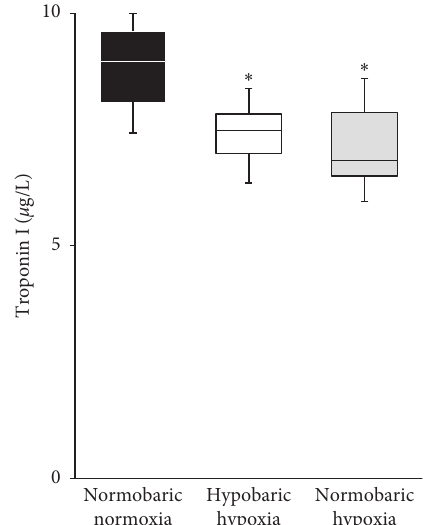
Figure 4: Plasma concentrations of troponin I in the three groups. Blood samples were collected from each group after 30 min of ischemia and 60min of reperfusion. Data are shown as median and interquartile range (IQR), n � 8 rats per group. ∗ p < 0.01 vs. nor- mobaric normoxia group by one-way analysis of variance (ANOVA) followed by Tukey’s post hoc test.